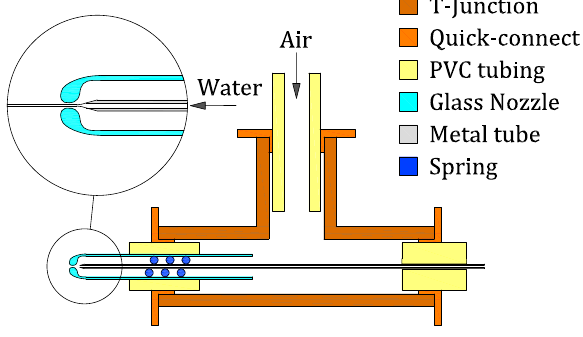
Figure 17. Assembly of the GDVN